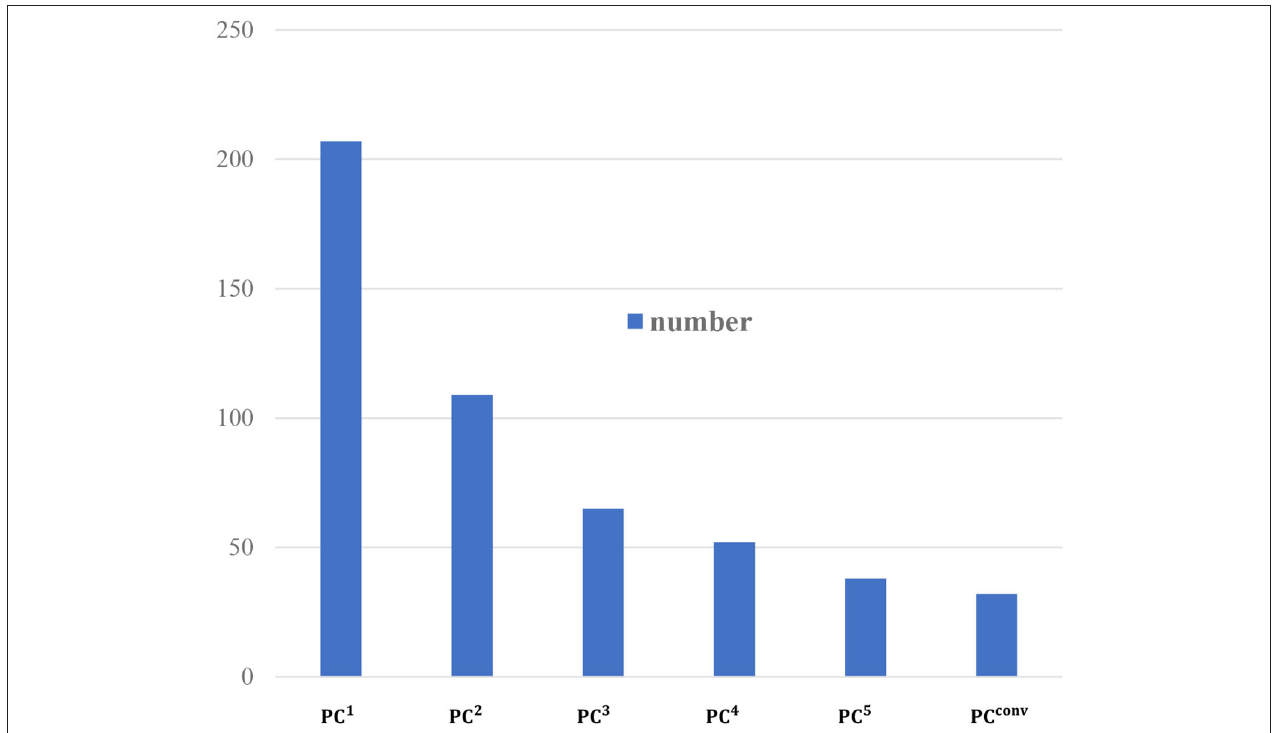
FIGURE 10 | The number of selected features with p -values =